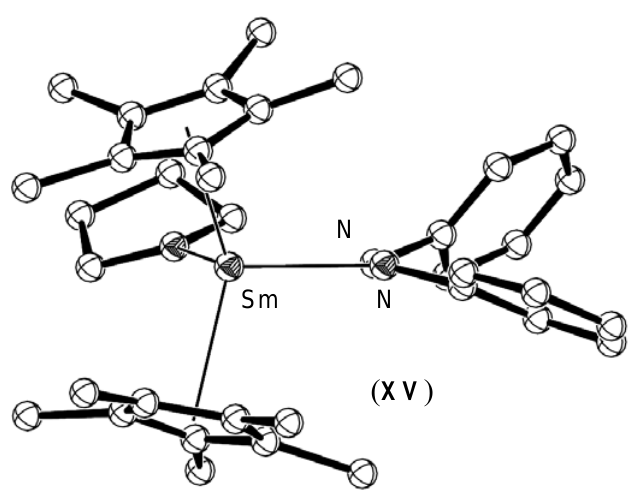
Figure 7. Molecular structure of [(C from CCDC obtained coordinates. Atoms of arbitrary size. H atoms and one of the two independent molecules in the asymmetric unit are omitted for clarity [49].